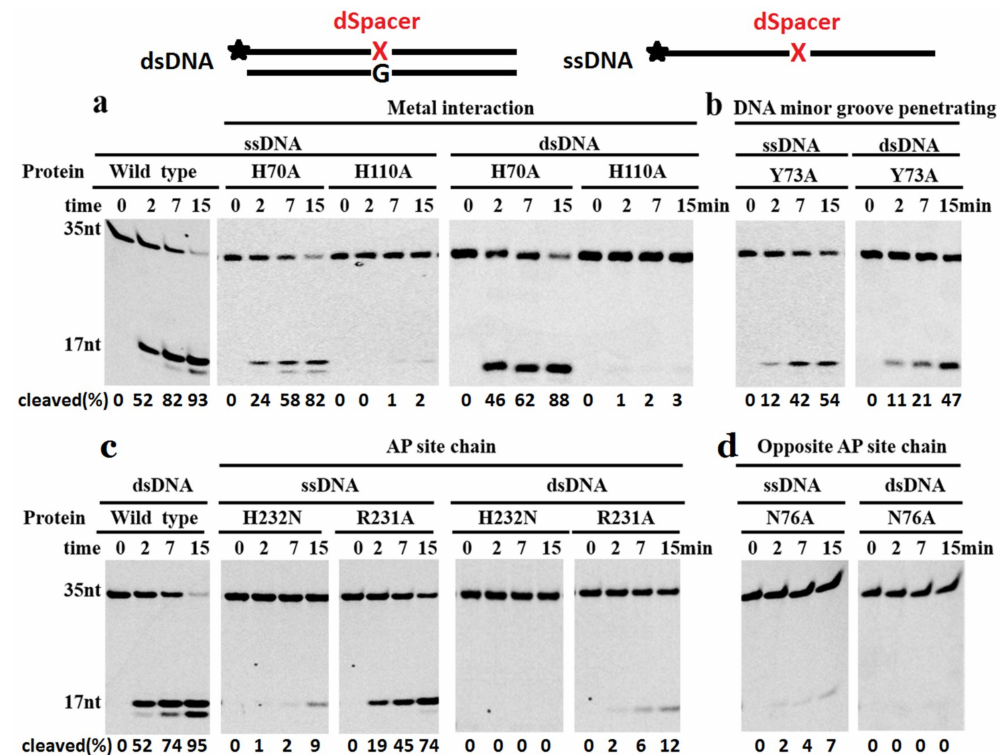
Figure 8. Cleavage reactions of wt (wild type) and mutant TeuendoIV. Mutations on key conserved residues potentially involved in ( a ) coordinating metal ion cofactors, ( b ) penetrating into the duplex minor groove, and binding the ( c ) AP site-containing strand and ( d ) complementary strand were used to assay AP endonuclease activities (5 nM enzymes) on ssDNA and dsDNA with an internal dSpacer (100 nM) at 55 ◦ C for the indicated time. The cleavage percentages of substrates are listed at the bottom of each panel. The symbol of black asterisk and the red letter X denote the fluorescein (6-FAM) group at the 5 (cid:48) -end and the AP-site,